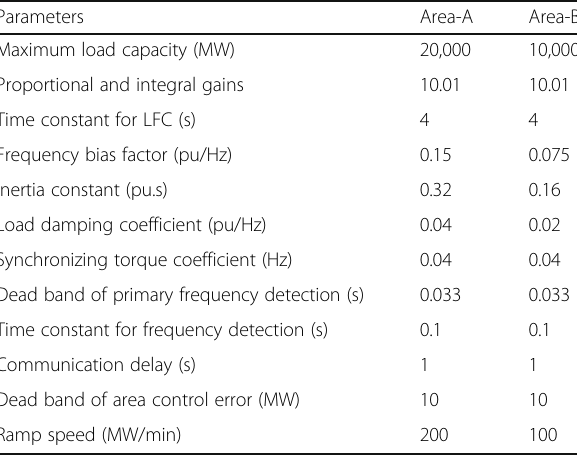
Table 1 Parameters of power systems